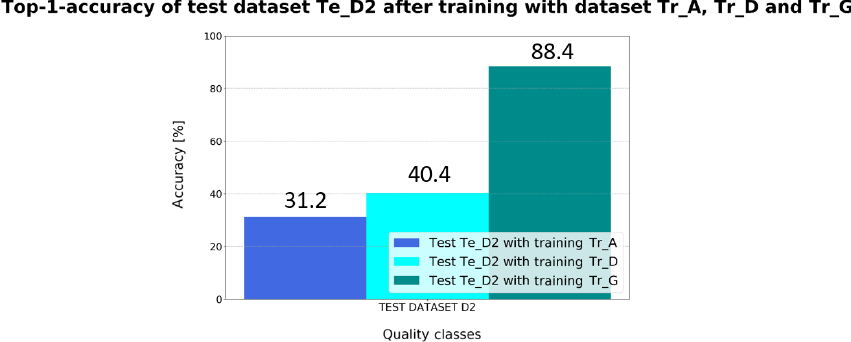
Figure 10. Detection accuracy on test dataset Te_D2 depending on the different training